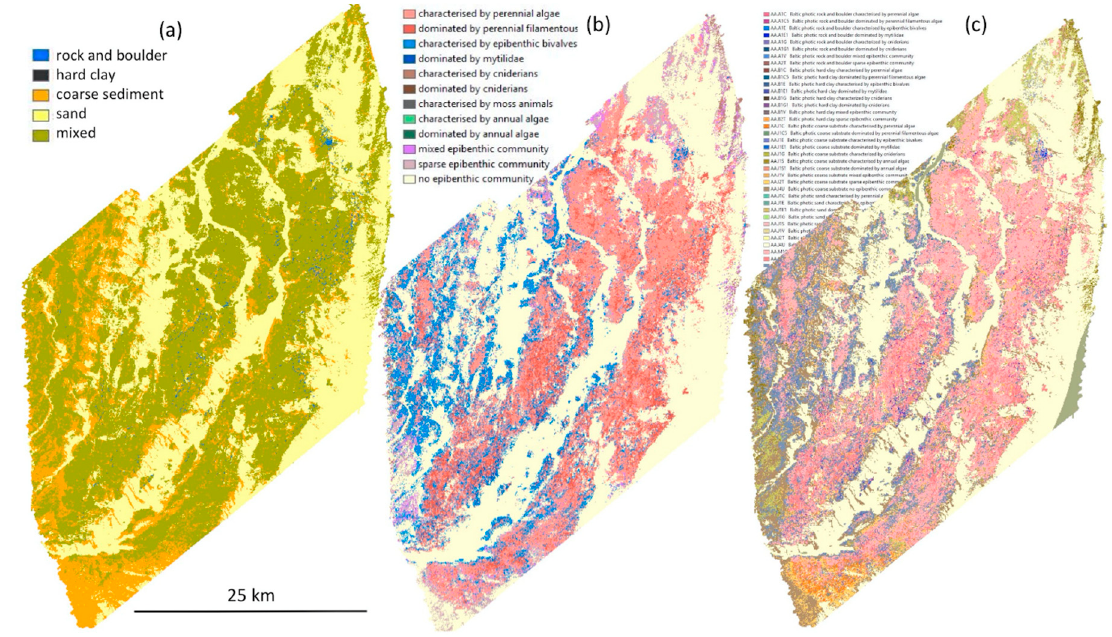
Figure 10. ( a ) HUB level 3, ( b ) HUB 4–6 (12 classes found), ( c ) HUB 1–6 (59 classes found, see Supplementary materials Legend S1, Table S3 and Map S1 for enlarged legend, map and more details). HELCOM HUB is a hierarchical classification scheme that consists of six levels with biotopes defined by applying split rules similar to a dichotomous key. The first 3 levels describe habitats (region, vertical zone, substrate) whilst levels 4–6 describe biotopes (community structure, characterizing community, dominating taxa).